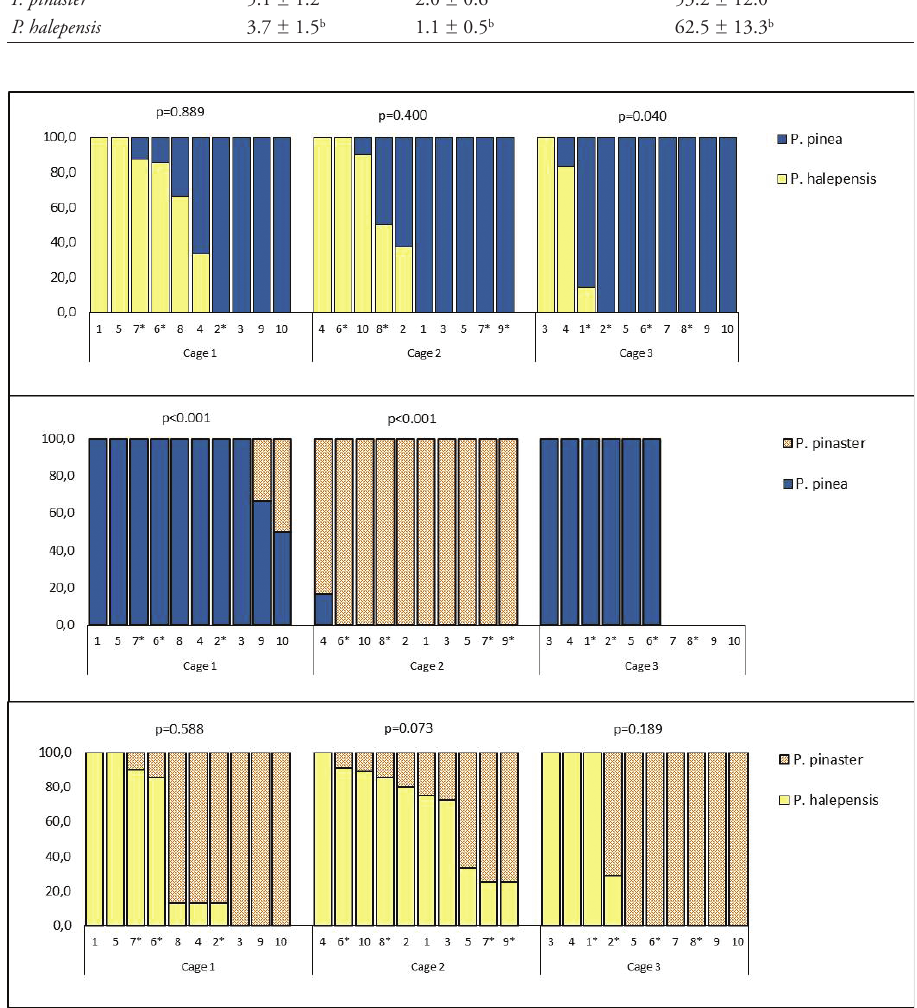
Figure 1. Branch preference trials. Bugs distribution per host in each cage and for each host pair com- parison in the preference trials using potted branches. Numbers with asterisk on the x axis correspond to male bugs. The absence of bars means that individuals were never observed on the branches during the trial, but remained on the floor or on the walls of the